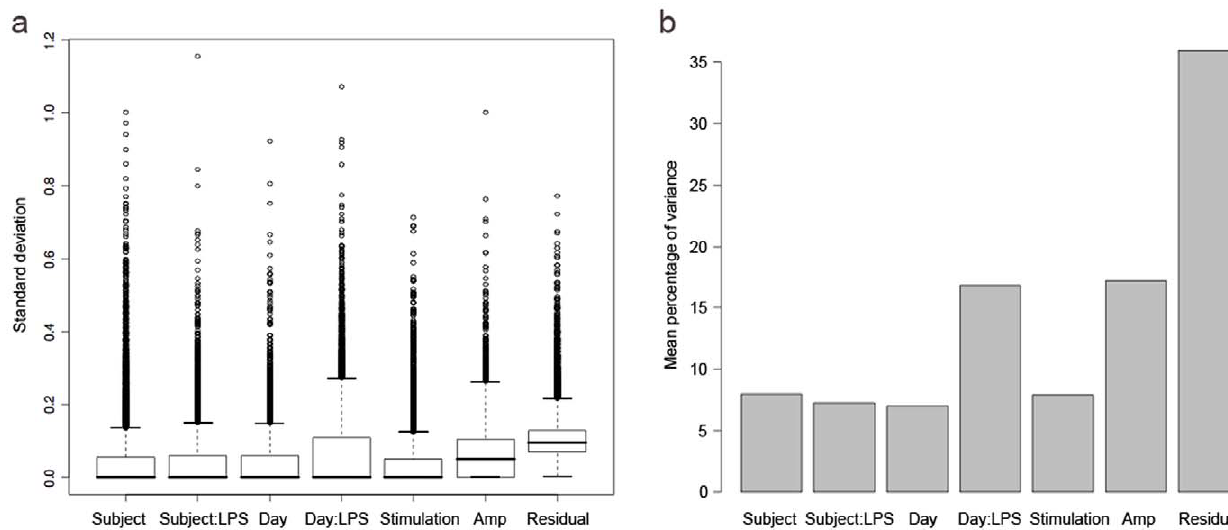
Figure 3. Variability of gene expression for each component level of the experiment. a) Standard deviation of all genes for each variance component, showing median standard deviation, interquartile ranges and outliers; b) Proportion of variance contributed by each component to the overall variance. Amp - amplification run.